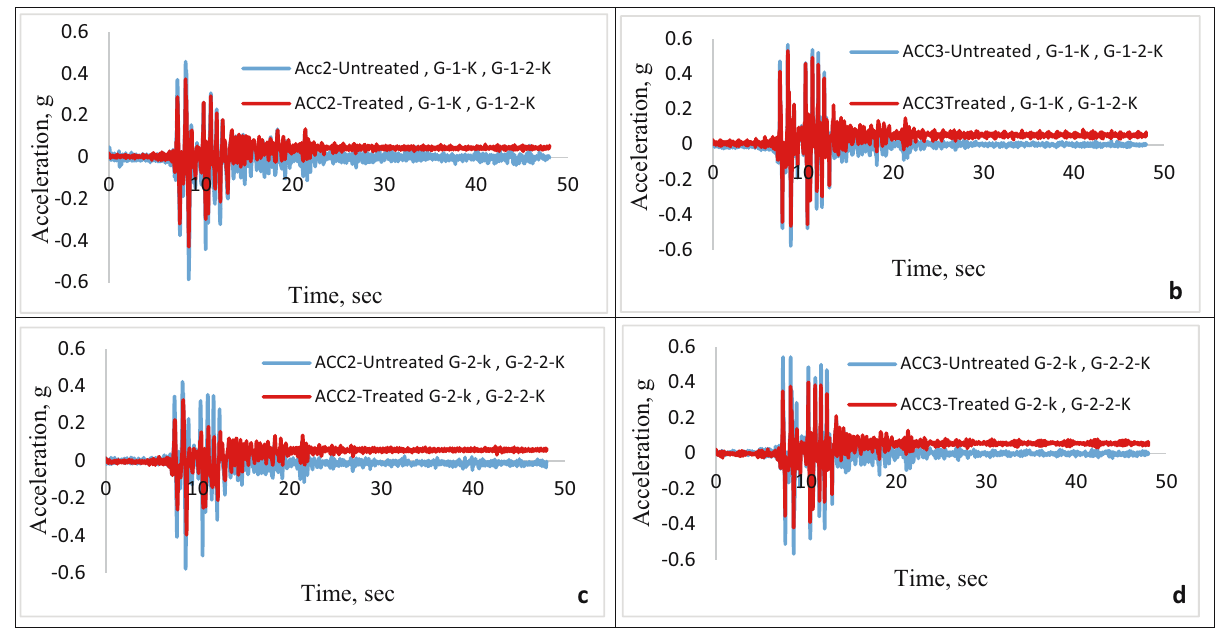
Figure 11: Acceleration within di ff erent depths of treated and untreated soil with nano - SiO 2 : ( a and b ) ACC2 and ACC3 at 50% axial load and 50% axial load and 100% lateral load; ( c and d ) ACC2 and ACC3 at 100% axial load and 100% axial load and 100% lateral load.